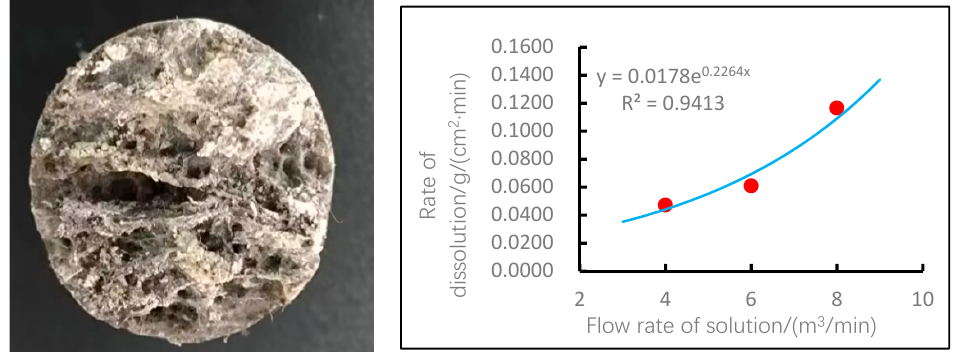
Figure 6. Dissolution of rock samples in solutions of different flow rates in 30 min. ( Left ) salt-dissolved morphology of 6 m 3 /min flow rate; ( Right ) Influence curve of solution with different flow rate on dissolution rate